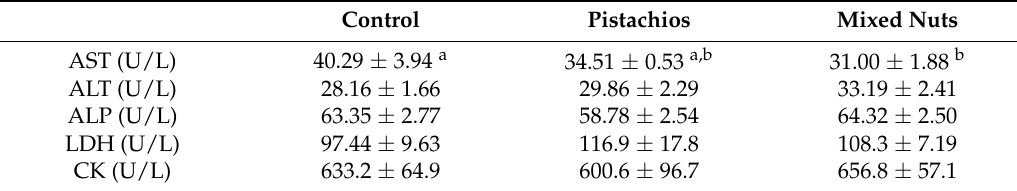
Table 2. Liver function enzyme activities in rats.